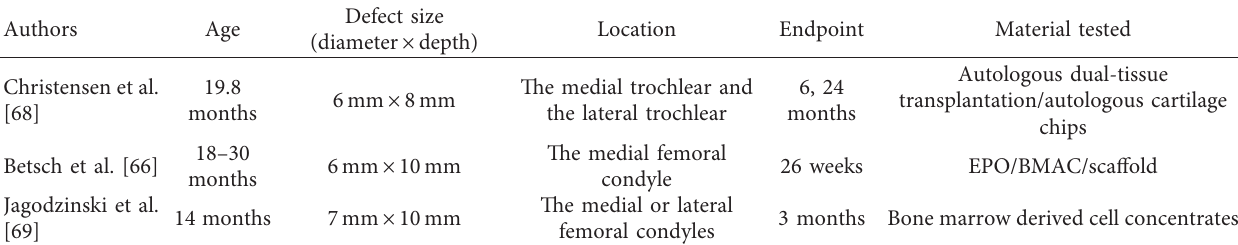
Table 5: Examples of studies using pig osteochondral defect